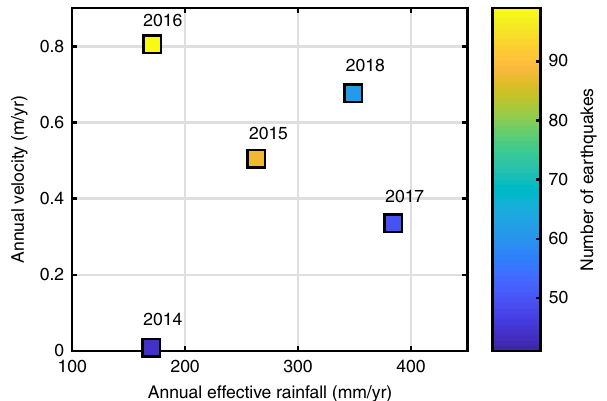
Fig. 3 Annual landslide velocity as a function of effective annual rainfall. Colors indicate the number of earthquakes with PGV at the landslide location above 0.01 cm.s − 1 . See SI and Supplementary Fig. 6 for more information. The effective annual rainfall corresponds to the cumulative effective precipitation between December until mid-August of each year. The cumulative displacement for each year corresponds to the total displacement between the fi rst and the last date of the rainy season were the landslide ’ s velocity is above a certain threshold (set at 0.039 m.yr − 1 ). Earthquakes are counted only in between 2 weeks prior to the acceleration of the landslide, up to when the motion ceases in each rainy season. The displacement and seismicity following the August 2016 earthquake are not taken into account for 2016. These periods are summarized in the Supplementary Fig. 6 and Supplementary Note